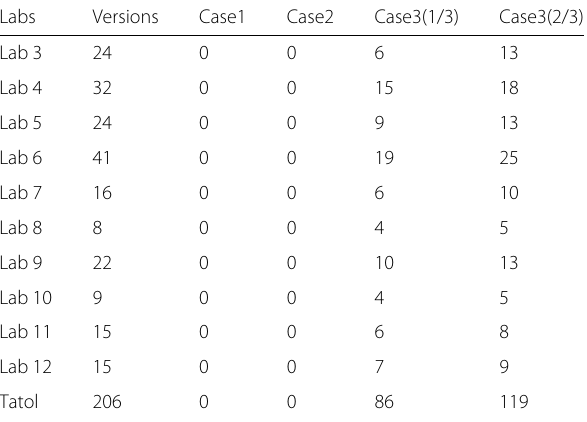
Table 3 False positives of fault localization in three